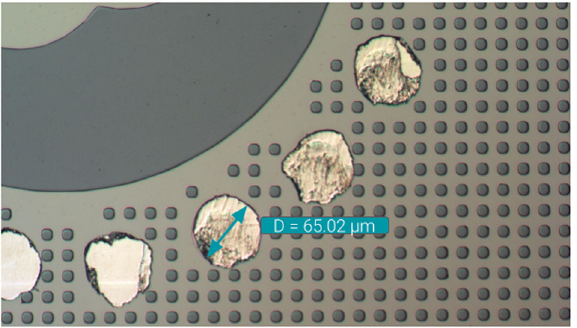
Fig. 6 Magni fi ed image of a region of the carrier chip. This image shows the indium bumps post-bonding and post-shearing, a destructive process whereby a cut is made through the device separating the QuIC chips from the carrier chip. The diameter and height of the indium bumps are known pre-bonding, such that by measuring the bump diameter post-bonding, a rough estimate for the bump height can be obtained assuming the bump is cylindrical in both cases: h post ¼ h pre D pre = D post the conductance measurement itself. The qubit anharmonicities are compared with the design target and are accurate to within 11%, demonstrating a systematic offset that will be corrected in future designs. The device Hamiltonian is designed to enable parametric gates between